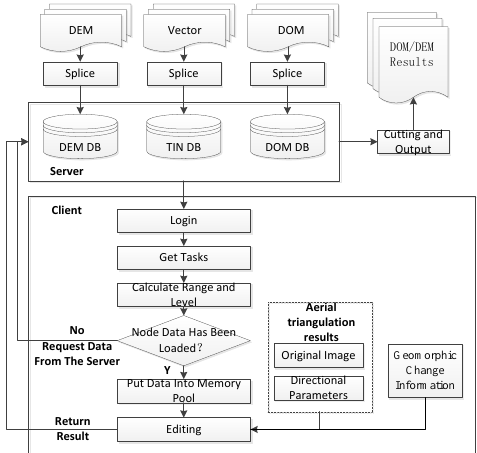
Figure 2. DOM and DEM Update Production